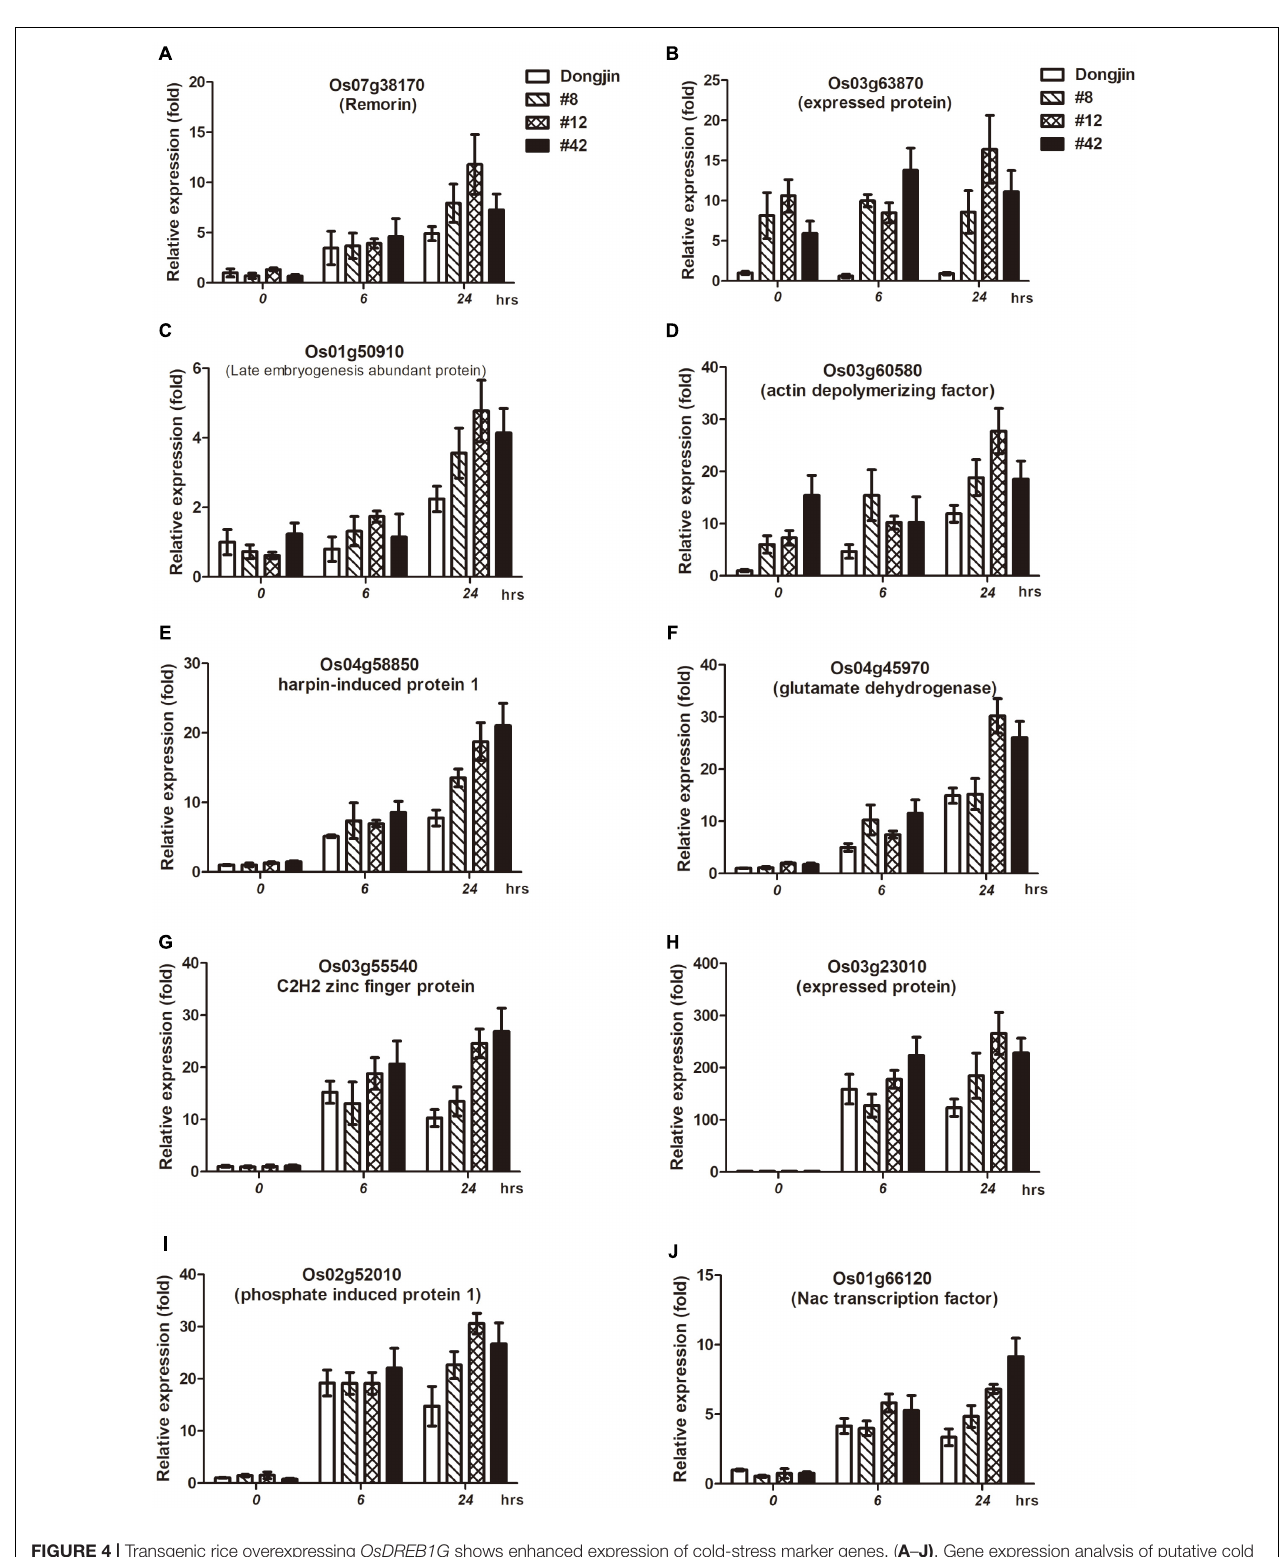
FIGURE 4 | Transgenic rice overexpressing OsDREB1G shows enhanced expression of cold-stress marker genes. ( A – J) , Gene expression analysis of putative cold stress-responsive genes in T2 transgenic rice plants overexpressing OsDREB1G under cold stress condition. RNA was isolated from 2-week-old plants treated with cold (4 ◦ C) in different time intervals. All RT-qPCR were performed using same conditions. Error bars indicate standard deviations. The experiments were performed with at least three biological repetitions.